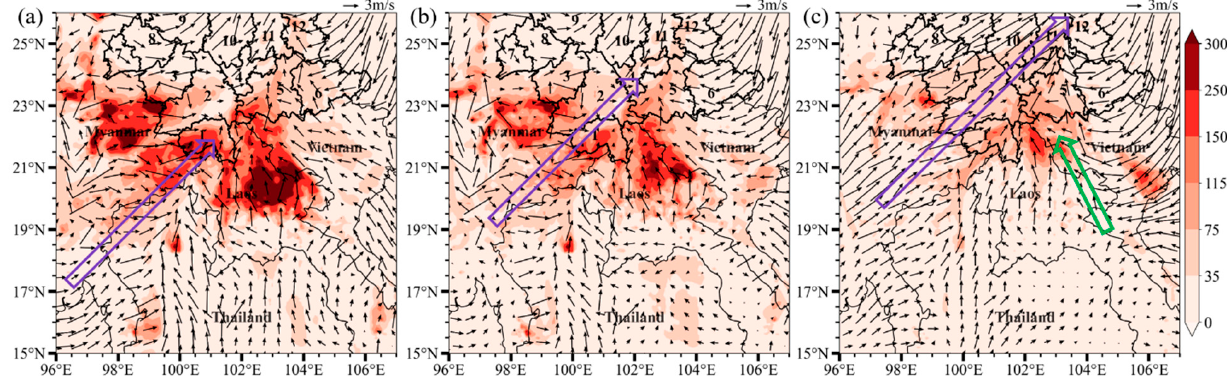
Figure 5. Spatial distribution of surface PM 2.5 concentrations and 10 m wind vectors simulated at ( a ) 02:00 of 25 March, ( b ) 10:00 of 25 March, and ( c ) 20:00 of 25 March. The purple arrows highlight the major southwesterly winds, and the green arrow in ( c ) highlights the major southeasterly winds.